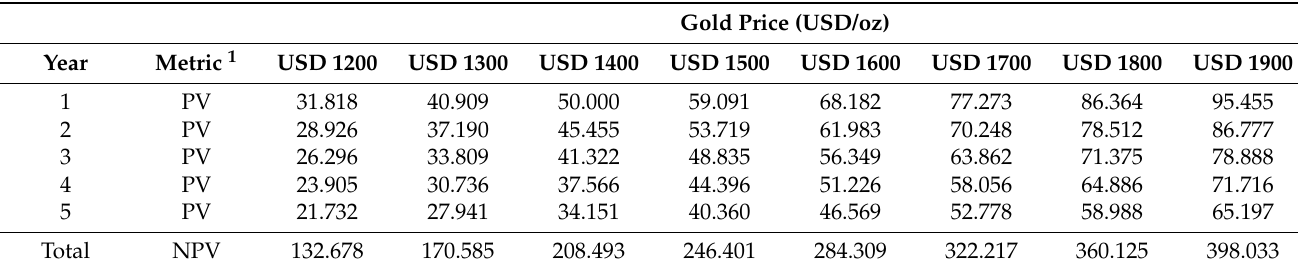
Table 4. Summary of net present value (NPV) calculations for a range of potential gold prices under Option 1, assuming a production rate of 100 koz Au/y and all-in sustaining costs (AISC) of USD 850/oz.